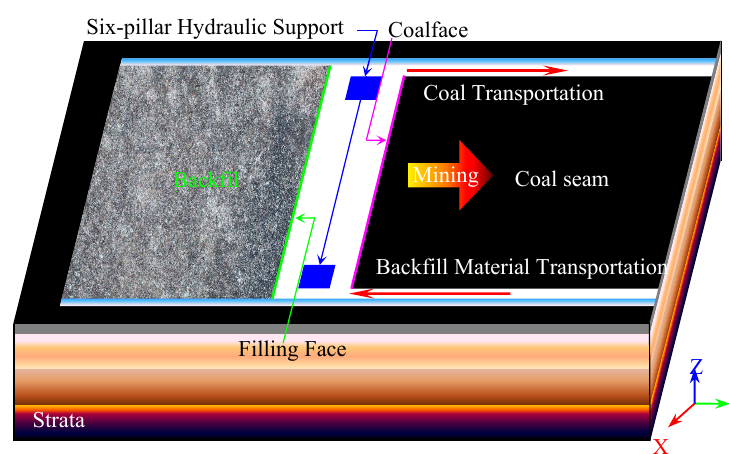
Figure 9. Schematic diagram of coalface in filling mining.